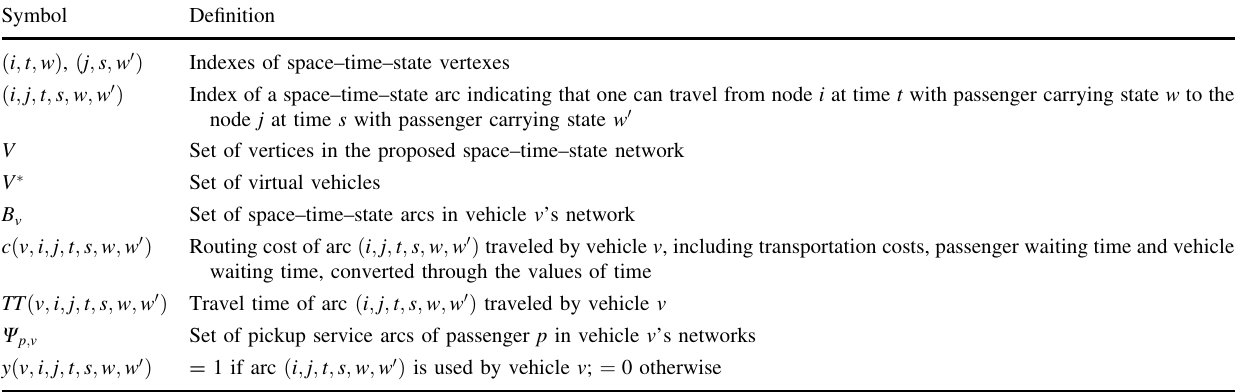
Table 4 Indexes and variables used for the model